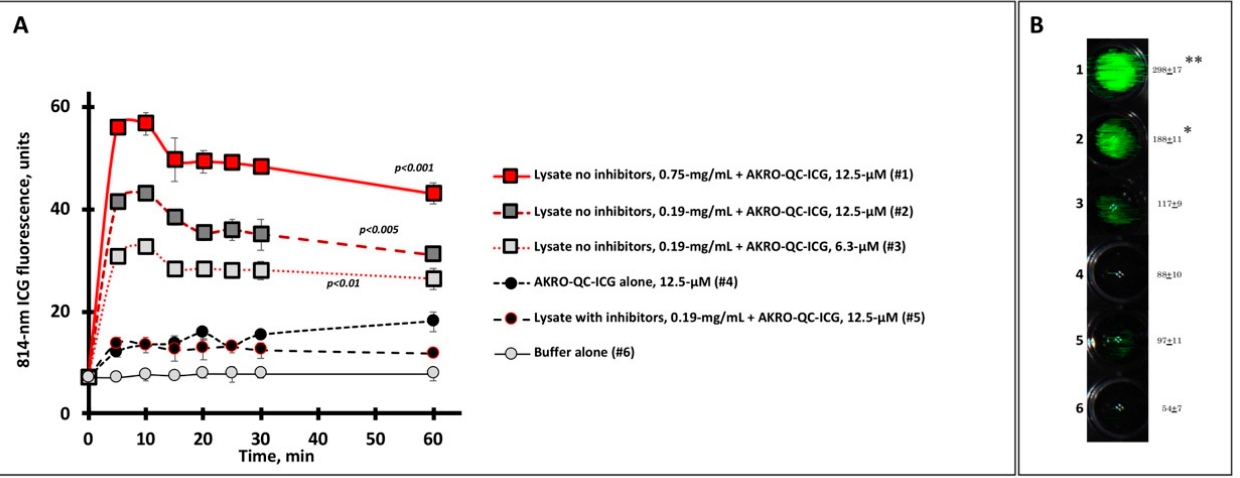
Figure 2. Human BCa cell lysate initiates specific fluorescence imaging of AKRO-QC-ICG probe in vitro. ( A )—Time course of ICG fluorescence imaging of cancer-cell-associated cysteine cathepsins (lysate) mixed with substrate (AKRO-QC-ICG). Tecan fluorescent scanner was used to assess ICG fluorescence in 4 wells per sample for different mixes, probe alone, or buffer alone (100 µ L per well, 96-well black flat bottom plate) in three experiments. Irreversible cysteine protease inhibitor K777 was used as a control for specificity of fluorescence. Vertical bars—SD. ( B )—Representative sample of ICG FL in AKRO-QC-ICG/MDA-MB-468 cancer cell lysate mixes after 10 min incubation. Data presented as mean fluorescence ± SD in 3 wells per sample. Number of wells corresponds to the number of samples tested in ( A ). Quantification of well signal in arbitrary units after 10 min of incubation is presented to the right of each well. Imaging of lysate spots was performed using the Curadel Lab-Flare RP1 with 800 nm filter set and Curadel Resvet Imaging software. Notes: (1) the levels of fluorescence of all lysates without inhibitor were significantly higher as compared to controls (wells #4–#6) in (A); *— p < 0.05, **— p < 0.01 compared to controls (wells #4–#6) in (B) by Student’s t-test in three independent experiments both for (A) and